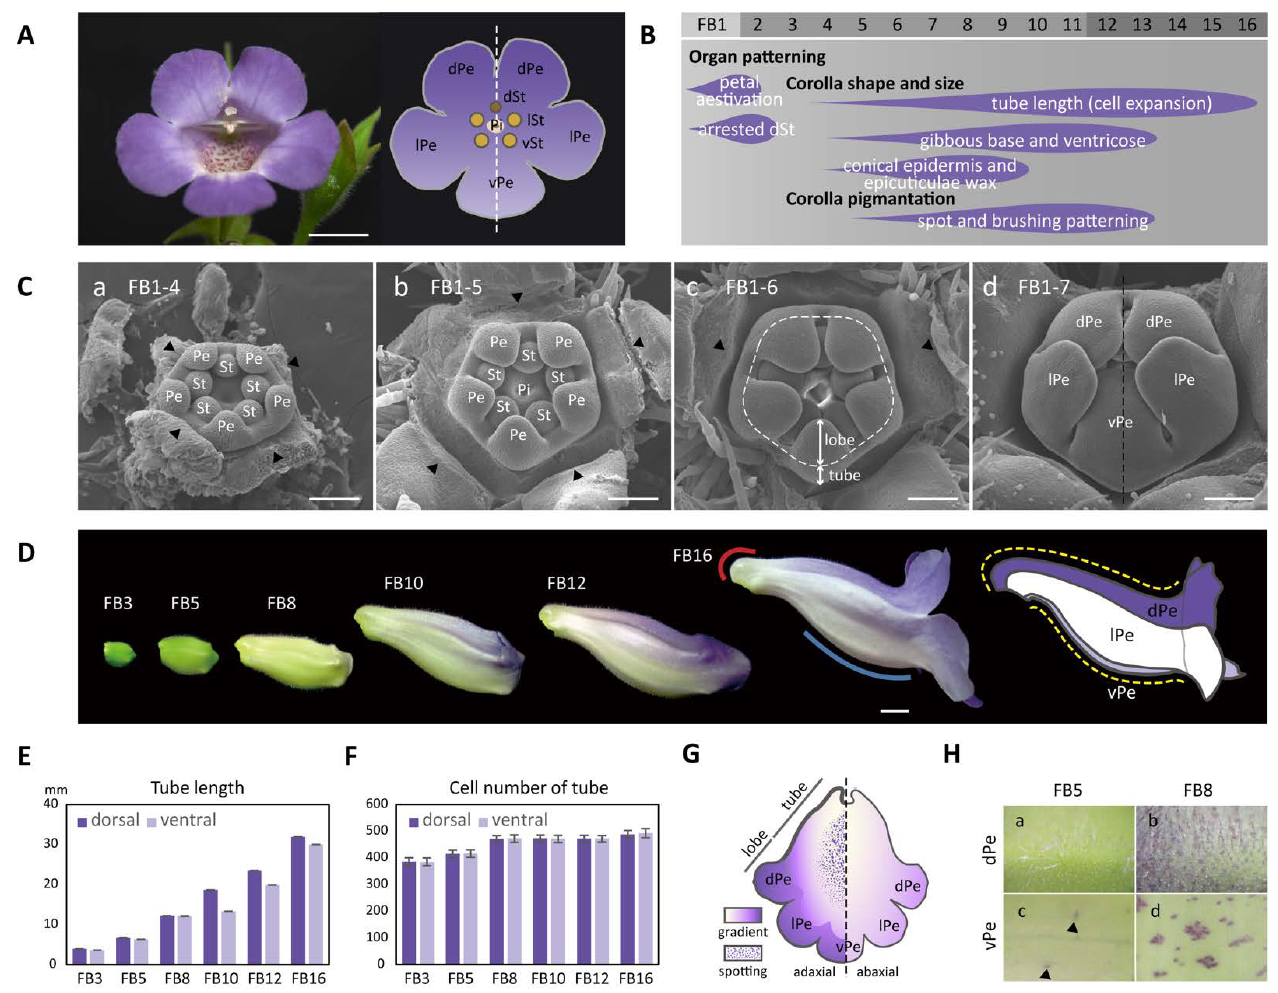
Figure 1. The establishment of dorsal–ventral petal asymmetry in shape, size, and pigmentation patterns in S. speciosa ‘ES’. ( A ) A front view of the fully opened zygomorphic flower (left) and the floral diagram (right). Scale bars = 10 mm. ( B ) The flower bud developmental stages marked with features of the asymmetric dorsal–ventral petal growth relating to corolla shape, size, and pigmentation. ( C ) SEM of floral organ primordia development along sub-stages (1-4~1-7) of floral bud stage 1 (FB1). Scale bars = 100 μm. ( a – c ) Petal and stamen primordia are equal in size (actinomorphy) during sub-stages FB1-4 to FB1-6. Arrowheads indicate the removed sepals and the dashed line in ( c ) marks the boundary between the corolla tube and petal lobes. ( d ) Initiated petal zygomorphy at FB1-7. ( D ) Corolla tube development from stages FB3 to FB16, during which the dorsal–ventral petal asymmetry is established gradually. The red and blue lines indicate a gibbous outgrowth at the base of the dorsal corolla tube (red curve), and a ventricose chamber (blue curve) at the ventral corolla tube. Refer to the main text for a detailed explanation. The dashed yellow lines demonstrate the tube length difference along the curvature of the dorsal and ventral corolla tubes. Scale bars = 5 mm. ( E , F ) The measurement of tube length ( E ) and cell number ( F ) between the dorsal and ventral parts of the corolla. ( G ) A cartoon illustration showing the gradient and spotting pigmentation patterns on the adaxial and abaxial surfaces of the corolla tube at FB16. ( H ) Purple pigments (anthocyanin) start to accumulate on cells of the adaxial surface of the dorsal petal at FB5 and become evident at FB8. ( a , b ) Purple spots also appear on the adaxial surface of the ventral petal at FB5 (arrowheads) but become obvious at FB8 ( c , d ). dPe, dorsal petal; lPe, lateral petal; vPe, ventral petal; dSt, dorsal staminode; lSt, lateral stamen; vSt, ventral stamen; Pi, pistil; Pe, petal; St, stamen